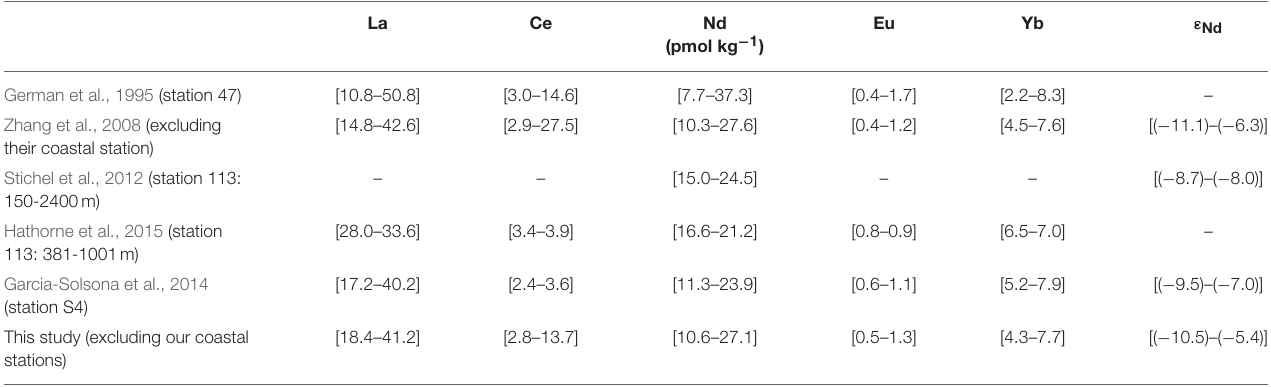
TABLE 2 | Comparison of our data with those from the literature.